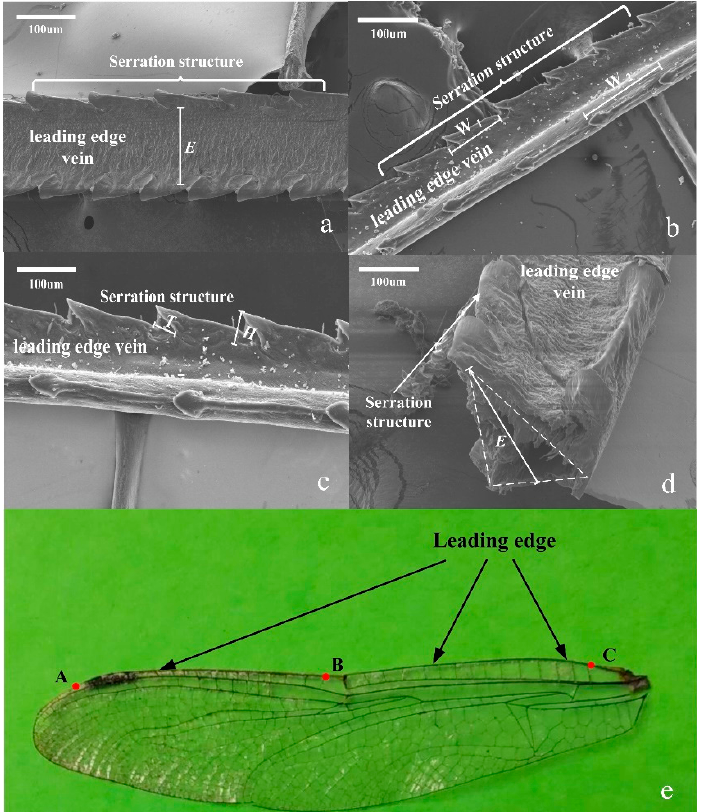
Table 1. Parameters of leading-edge wing vein microstructure ( μ m).